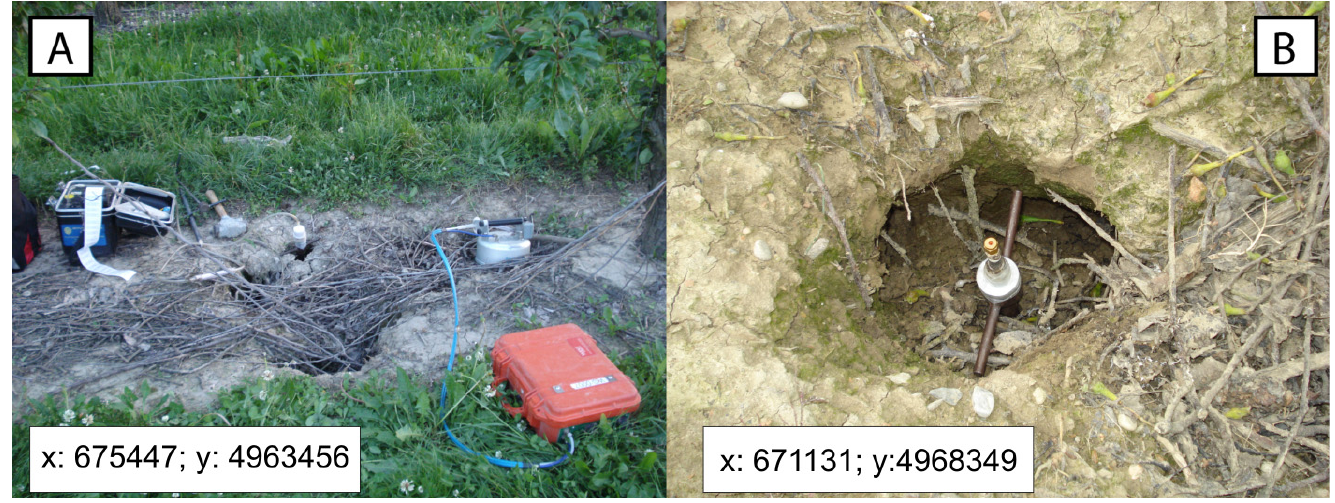
Figure 3. A, B. Soil-gas and flux measurements in collapsed caves. B. Detail of the steel probe driven into the collapsed caves to collect soil-gas samples. Geographic coordinates UTM WGS 84